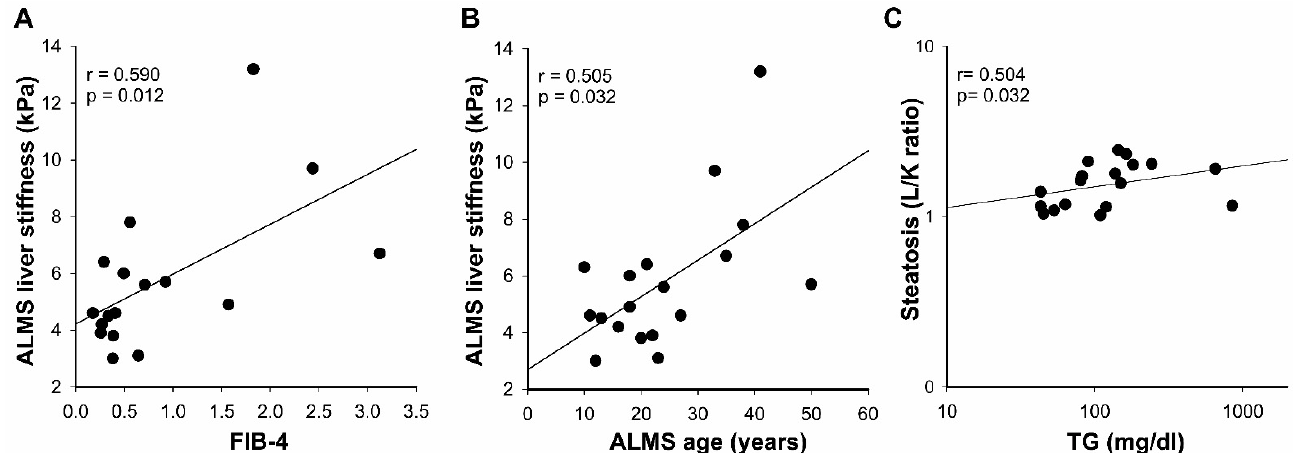
Figure 2. Correlation analysis of the liver stiffness and the sonographic hepatorenal ratio in patients with ALMS. The simple correlations between liver stiffness and FIB-4 ( A ), liver stiffness and age ( B ), and steatosis evaluated by L/K and TG levels ( C ) were performed by Spearman’s correlation in the 18 patients with ALMS. Data are reported on a logarithmic scale in ( C ).